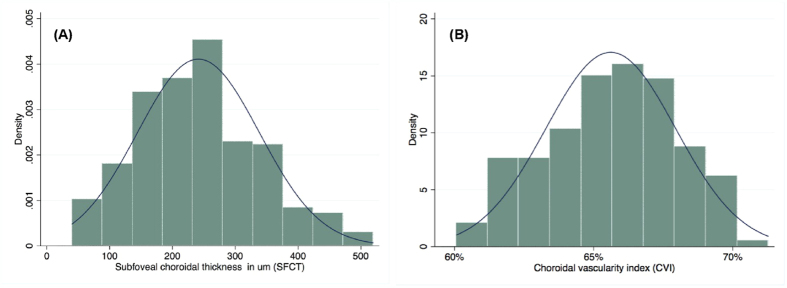
Distribution of subfoveal choroidal thickness (A) and choroidal vascularity index (B) across the population.